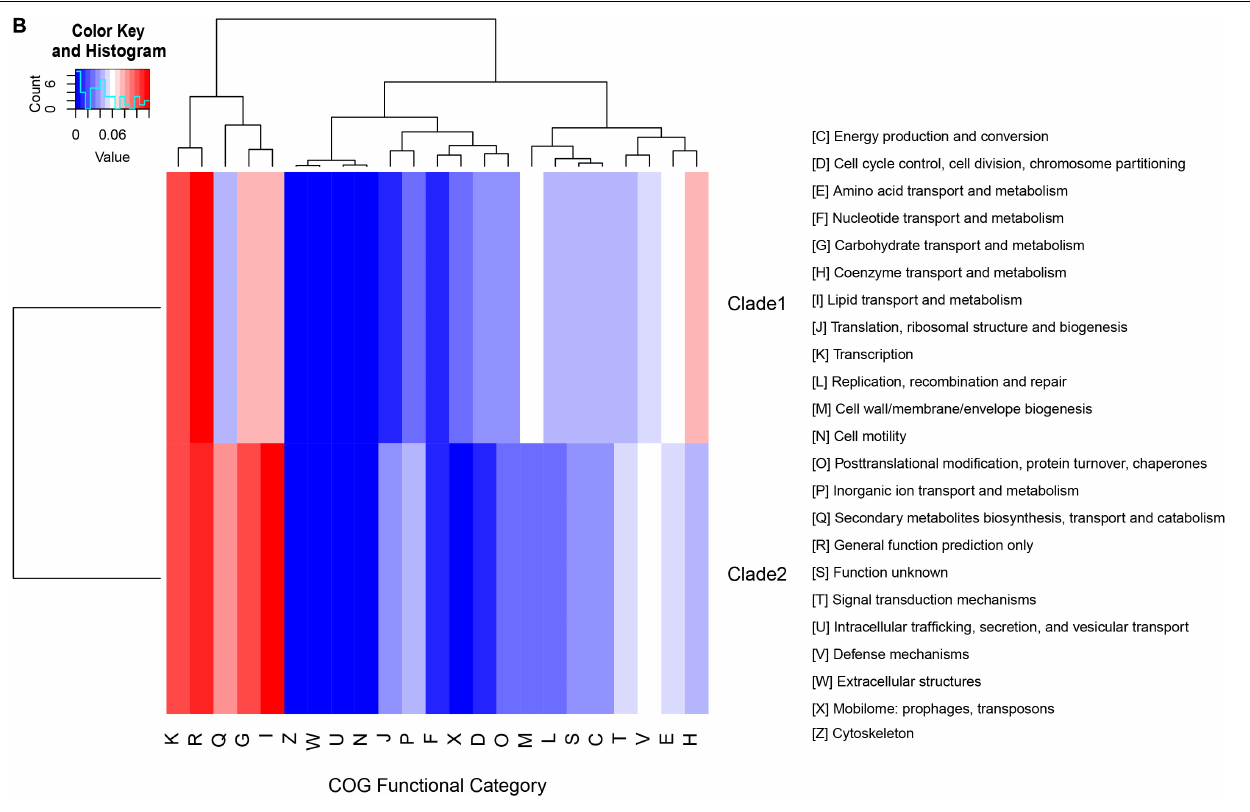
FIGURE 4B | Comparison of gene families between clade 1 and clade 2. The plot shows the tree compared to a matrix with the presence and absence of core and accessory genes (A) ; the bars between the tree and the matrix show to which clade/cluster the strain belongs. The heat map shows the relative abundance of the function classes corresponding to the unique orthogroups of clade 1 and clade 2 (B)